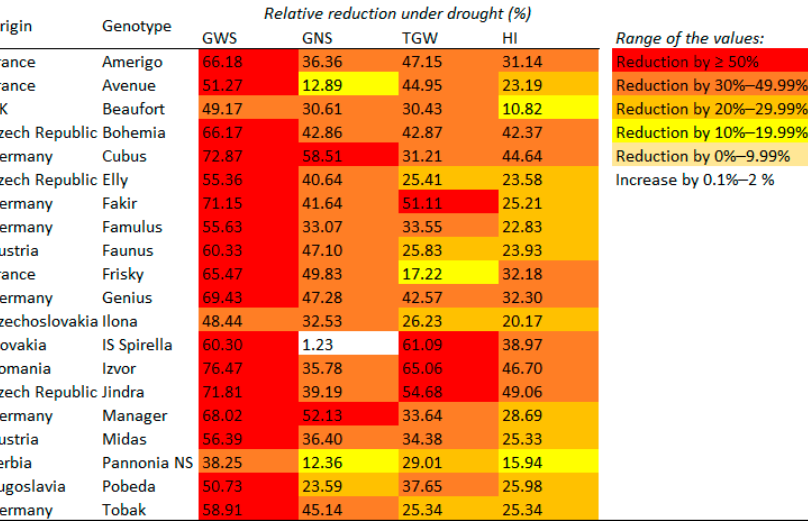
Figure 2. Mean values of GWS (g), GNS (pcs), TGW (g), and the HI (unitless) for each genotype, with standard errors of the means displayed as error bars. Two-way ANOVAs with Tukey’s post hoc tests were performed for all tested winter wheat genotypes for each yield formation parameter separately under control and drought stress treatments ( α = 0.05, n ≥ 4). Different letters above error bars denote statistically significant differences among treatments using Tukey’s post hoc tests. The blue lines represent the total mean values of the control treatments, and the orange dashed lines represent the total mean values of the drought stress treatments.